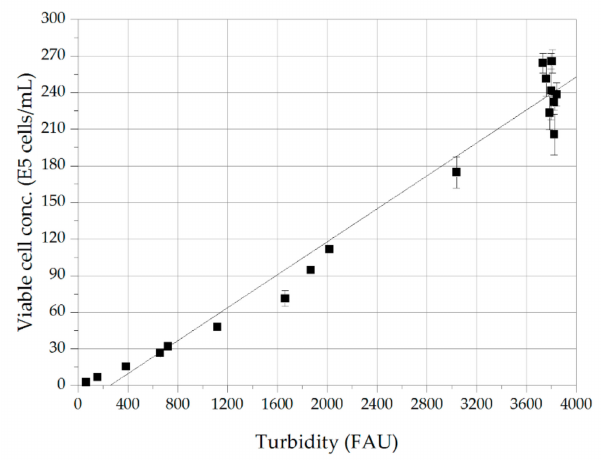
Figure 7. Linear correlation between viable cell concentration (1 × 105 cells / mL) and turbidity (FAU) with a slope of 0.068 ± 0.003 and an o ff set of − 17.40 ± 8.01. Error bars depict the double determination of cell